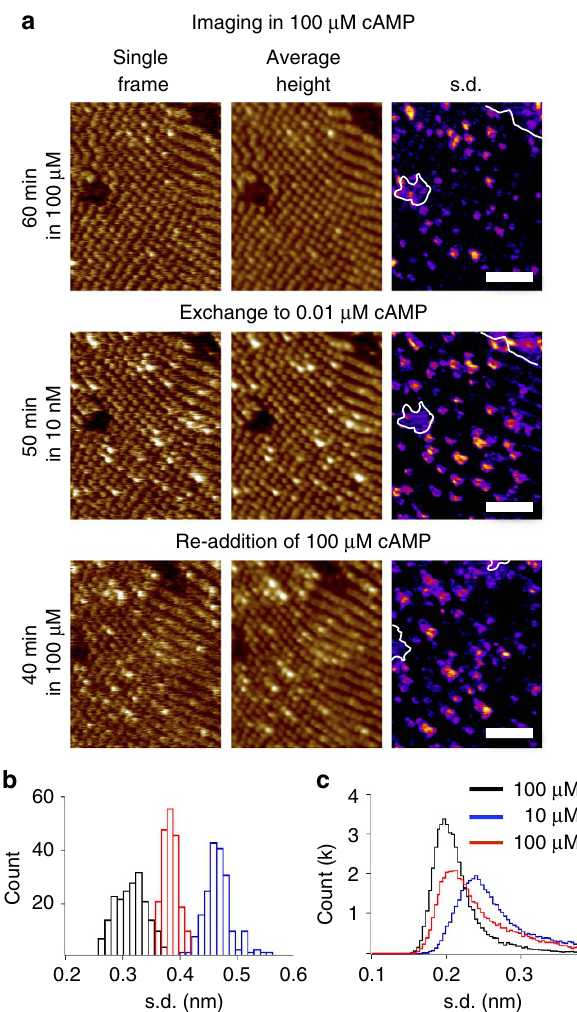
Figure 4 | Reversibility of CNBD blinking. ( a ) An identical membrane imaged in presence of 100 m M cAMP (upper), then in 10nM cAMP (middle), and after re-addition of 100 m M cAMP (lower). Single HS-AFM frames (left), average height topographies (centre) and the s.d. maps (right) of the movies are shown. Scale bar: 50nm. Full colour scale: 3nm. ( b ) Histograms of the s.d. of each original movie frame ( n ¼ 200) consisting of 30,000 pixel at 100 m M cAMP (black), 10nM cAMP (blue), and after re-introduction to 100 m M cAMP (red). An increase in the s.d. distributions reflects increasing height distributions. ( c ) Histograms of the s.d. maps of the movies ( a , right). The more blinking molecules, the higher the height variability.